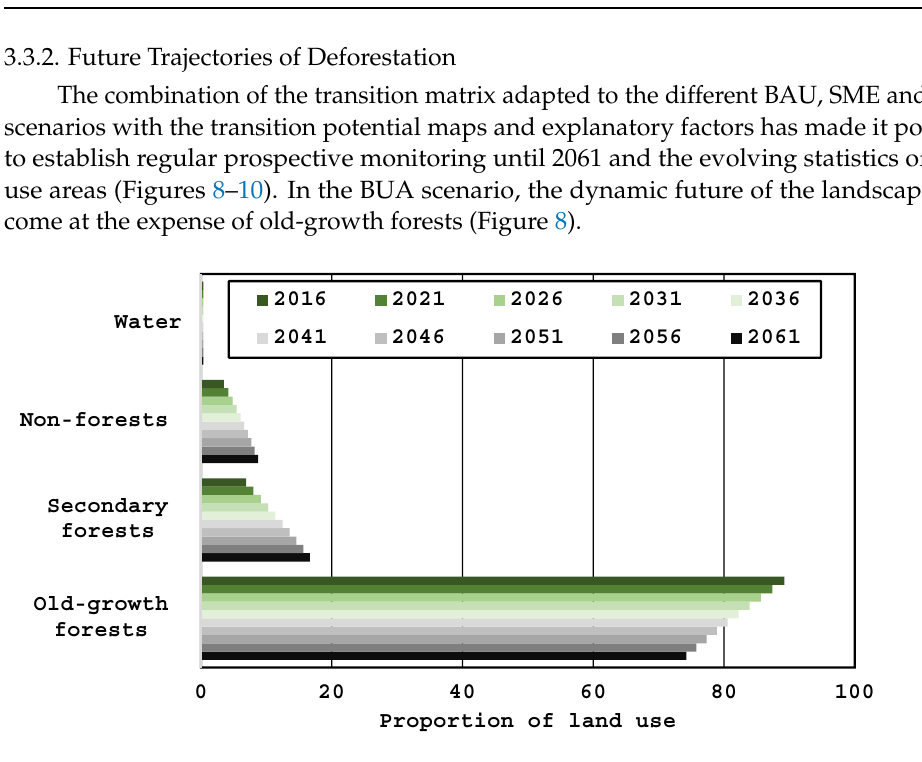
Figure 8. Future evolution of the composition of the occupation according to the trend scenario. In the SEM scenario, the dynamics of land use will benefit forests (Figure 9). Consid- ering the changes to be observed between 2016 and 2061, 8.84% of the proportion of the landscape occupied by old-growth forests will come from secondary forests (7.86%) and non-forests to secondary forests (2.73%). Furthermore, the non-forest class will experience a decrease in future years. They represent 3.50% of the proportion of the landscape in 2016. They will cover only 2.71% of the landscape by 2061. The proportion of the landscape that will remain unchanged is estimated at 87.03% of the total area of the landscape (re- spectively, 80.11% covered by old-growth forests, 5.95% by secondary forests, 0.66% non- forest and 0.31% water). Table 8 shows the transitions obtained in the SEM scenario be- tween 2016 and 2061. Table 8. Transition matrix in the SEM scenario between 2016 and 2061.